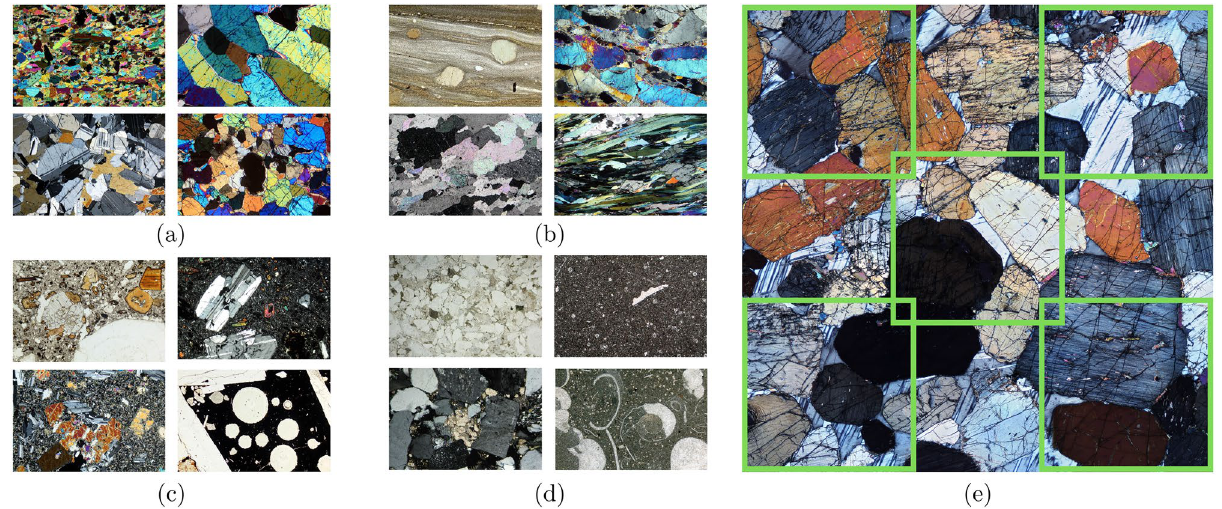
Figure 2. Four lithology classes extracted from Streckeisen dataset: ( a ) plutonic, ( b ) metamorphic, ( c ) volcanic and ( d ) sedimentary rocks in thin sections, ( e ) example of image slicing applied to the VPM dataset. Image slicing was applied to MacQuarie university images, splitting the original into five representative